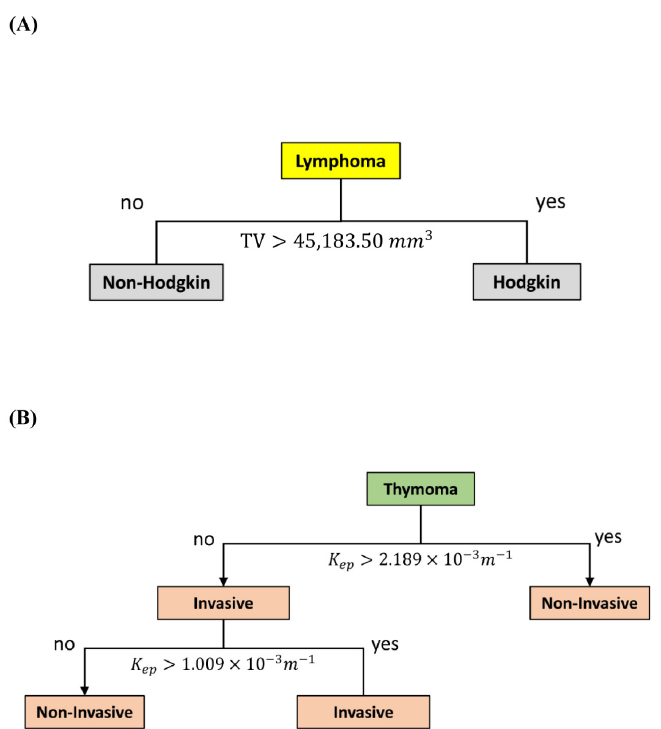
Figure 4. Decision tree models. ( A ) The model for differentiating Hodgkin from non-Hodgkin lymphoma with a total prediction accuracy of 88.24%. ( B ) The model for differentiating invasive from noninvasive thymoma with a total prediction accuracy of 90.32%. Abbreviation: K ep = efflux rate constant from tissue EES into the blood